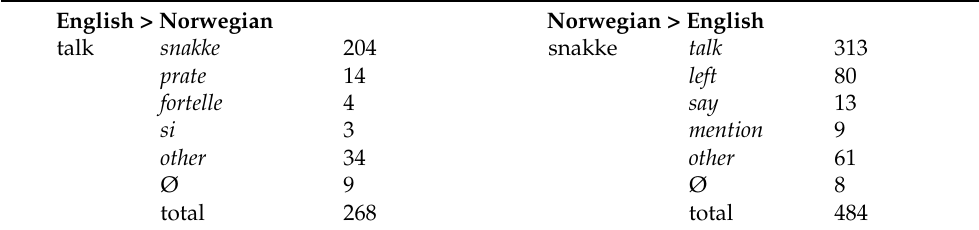
Table 1. Talk and Snakke in English<>Norwegian